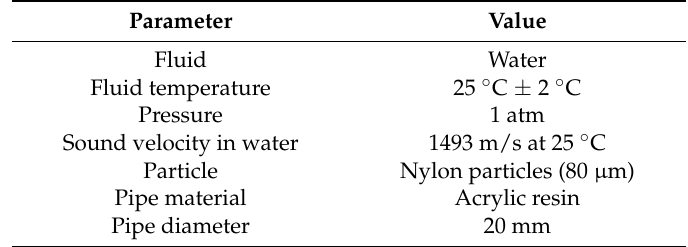
Table 4. Summary of experimental conditions.